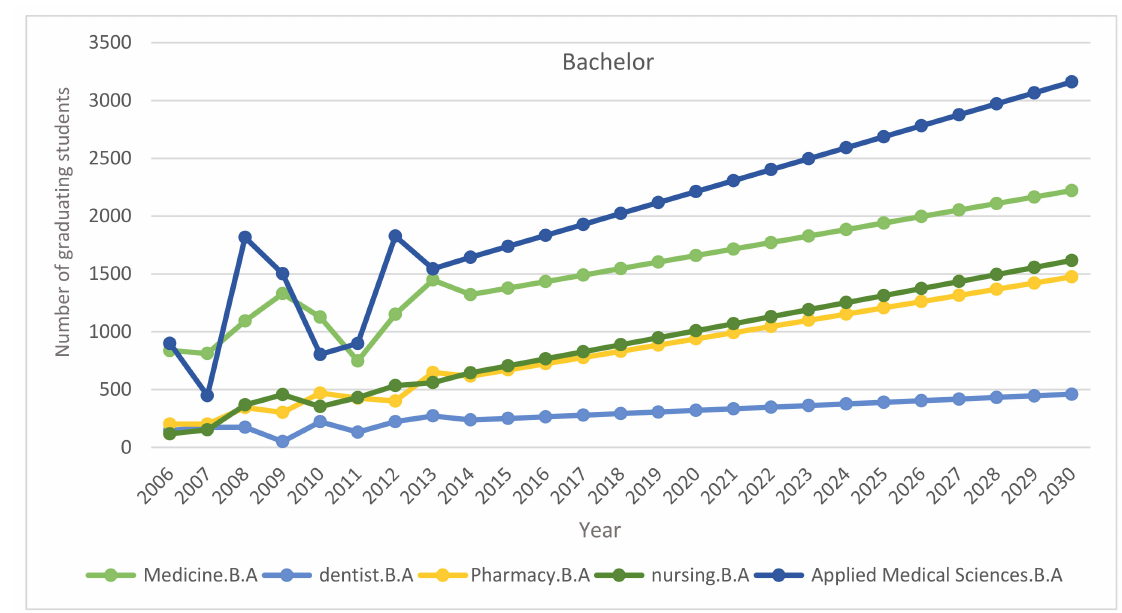
Figure 8. Number of graduating students from government and private medical